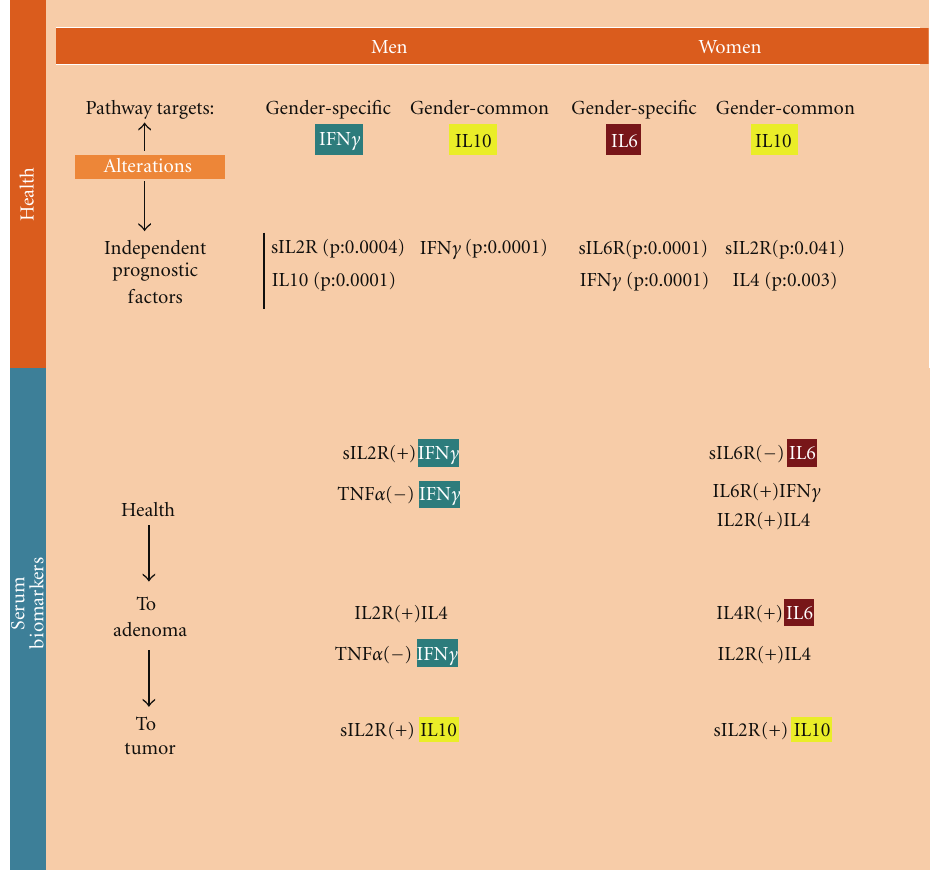
Figure 6: The results of the stepwise multiple regression analysis (using the forward procedure) indicate that the serum level of IFN γ in men could be a significant independent factor for predicting a possible alteration in IL10 regulation of the balance between Th1 and Th2 cell types. The independent factors sIL2R and IL10 are important for predicting an alteration in the normal regulation that IFN γ exerts over the balance between Th1 and Th2 cell types. In women sIL2R and IL4 may prove useful as significant independent factors to predict alterations in the normal regulation that IL10 exerts over the balance between Th1 and Th2 cell types; likewise sIL6R and IFN γ may prove useful as significant independent factors to predict alterations in the normal regulation that IL6 exerts over the balance between Th1 and Th2 cell